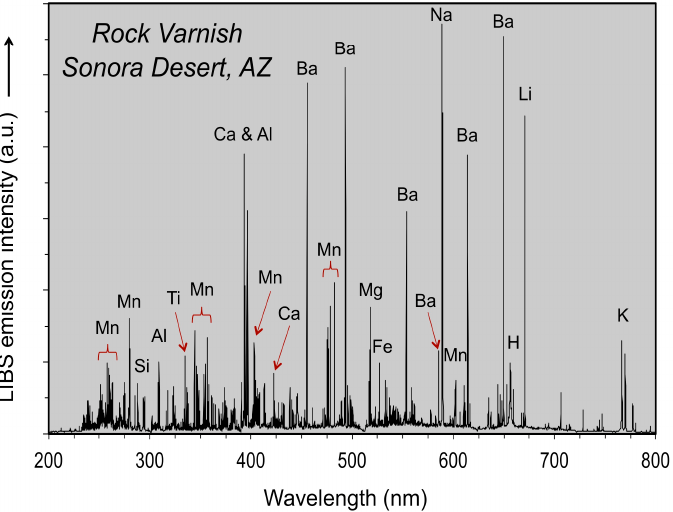
Figure 1. LIBS broadband spectrum acquired with a commercial laboratory LIBS system (Ocean Optics, Inc., Dunedin, FL, USA) for the surface of a varnished quartzite cobble from the desert pavement developed on an alluvial fan in the Sonora Desert near Yuma, Arizona.